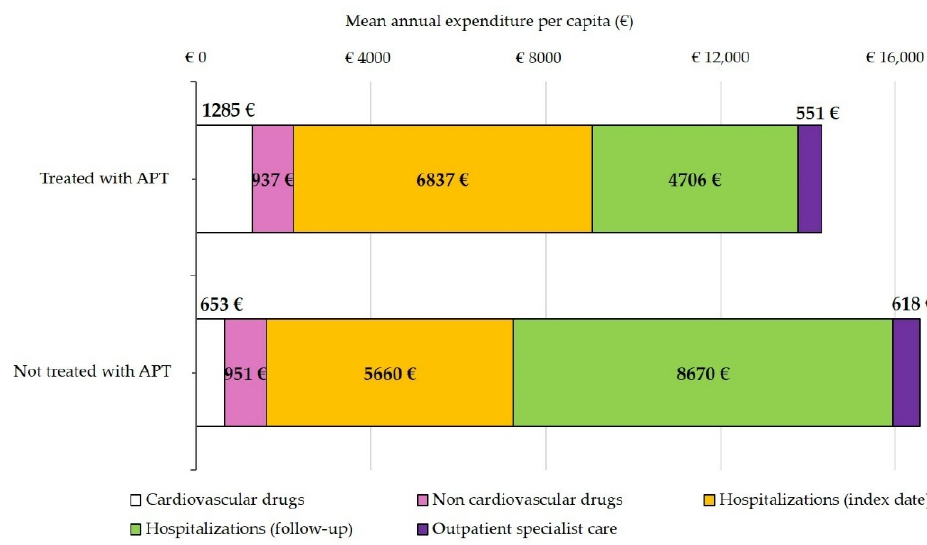
Figure 3. Mean annual per capita costs charged to the Italian National Health Service for acute coronary syndrome patients discharged in 2017, stratified by antiplatelet therapy (APT) at one month.